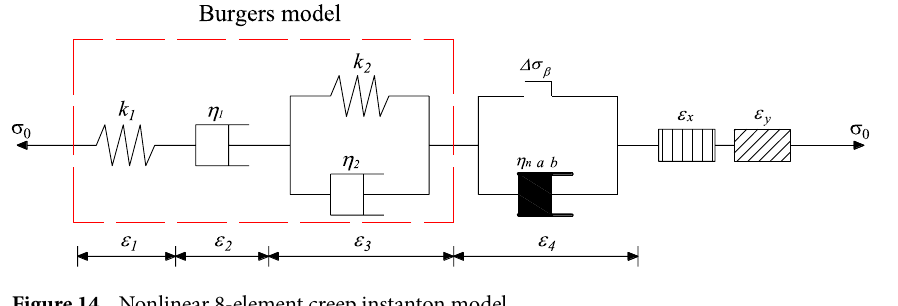
Figure 14. Nonlinear 8-element creep instanton